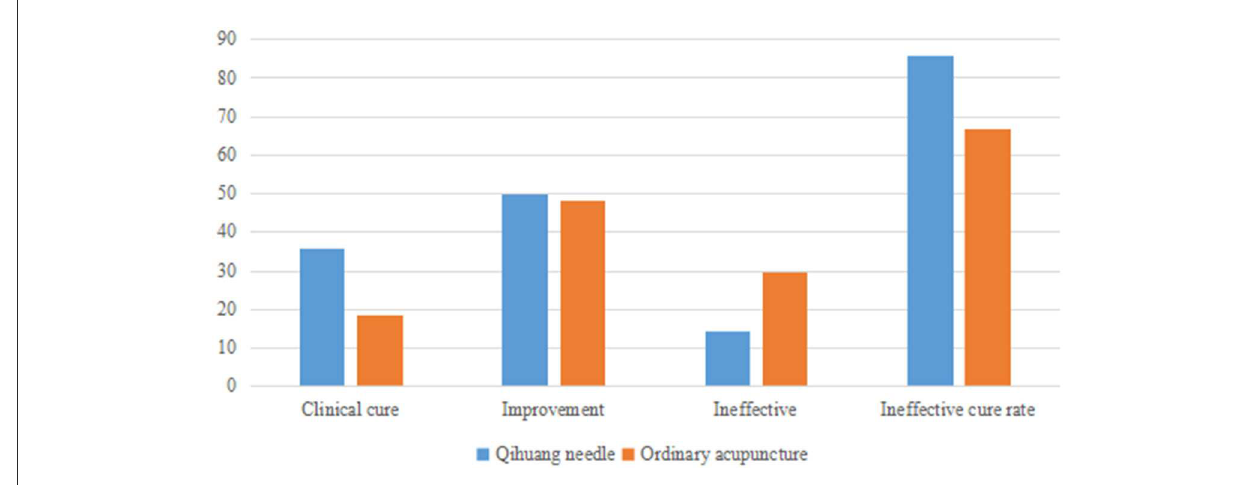
FIGURE4 A bar chart of the composition ratio of clinical efficacy in two